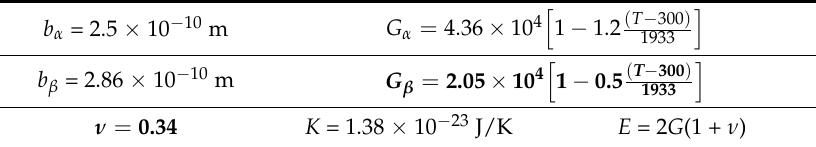
Table 3. Physical parameters of Ti-6Al-4V alloy